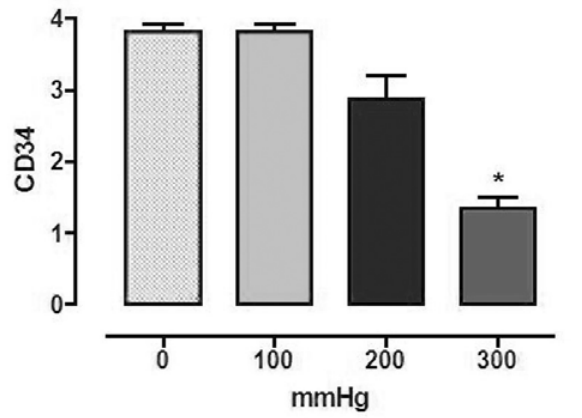
Fig. 3 - Expressão imunohistoquímica do CD 34 (n=20, ANOVA, p<0,05). O asterisco indica diferença estatisticamente significante. Análise semiquantitativa (a expressão foi graduada de + a ++++ por um único profissional, que desconhecia os grupos experimentais)